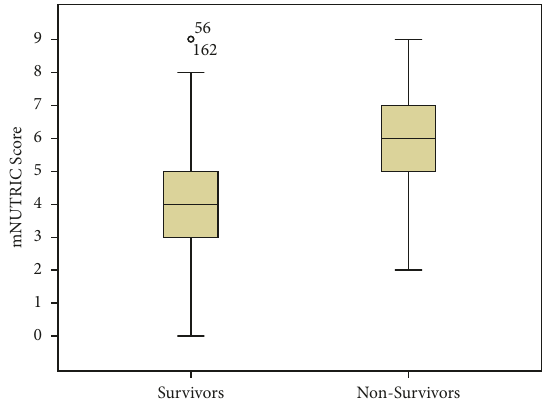
Figure 1: mNUTRIC score in survivors and nonsurvivors groups. mNUTRIC score: median 4 vs 6, P < 0 .